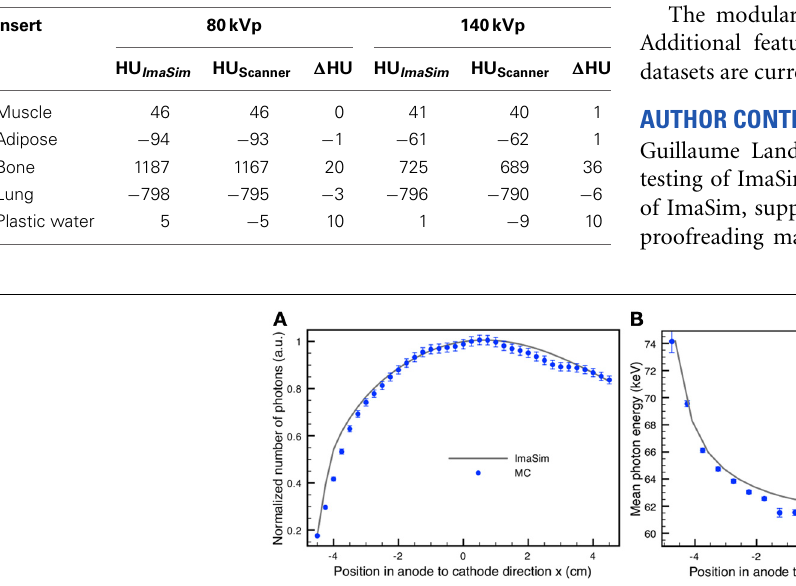
FIGURE 4 | (A) Comparison of central photon fluence profiles along the cathode anode direction produced by Monte Carlo simulation (circles) and ImaSim (solid line). (B) Comparison of